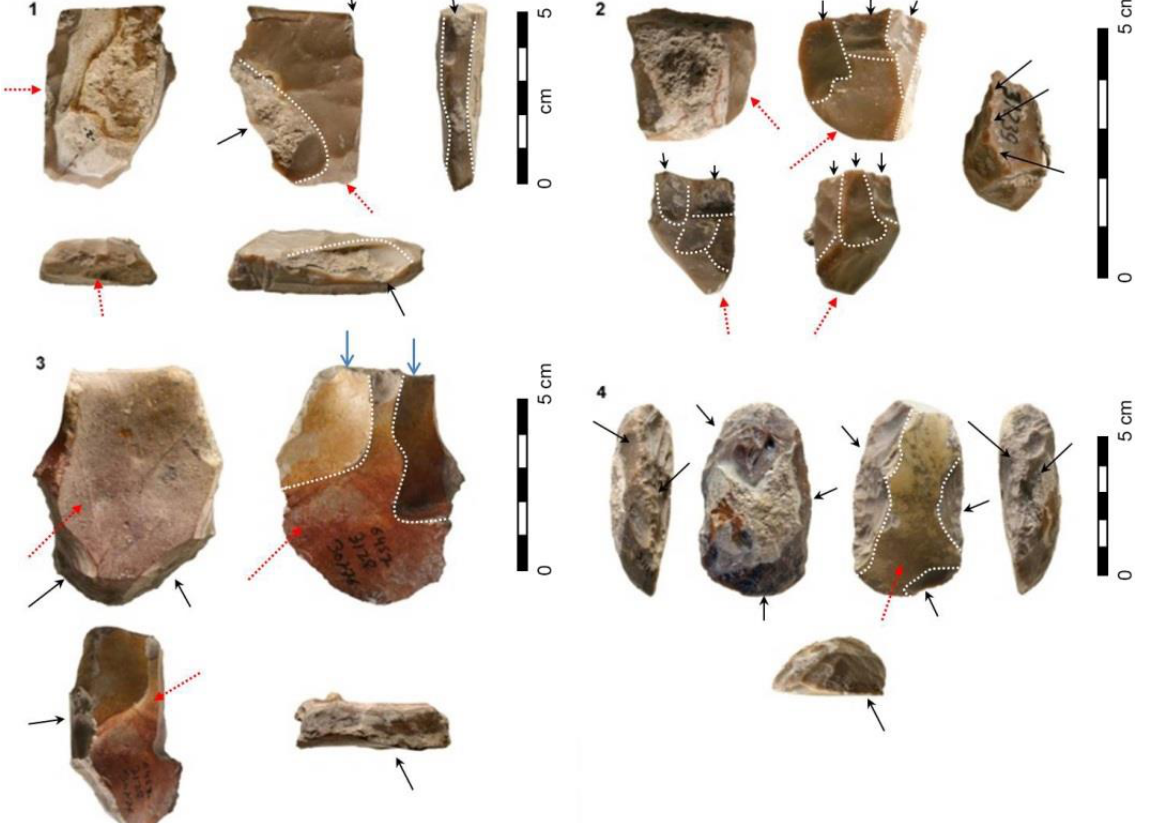
Figure 2. Examples of recycled items: (1 & 2) broken polished bifaces (the polish surface indicated by dotted red arrows) recycled into cores, as the removals are conducted from the broken surface and cut the bifacial scars (the removals are indicated by black arrows; dotted white line outlines the scars of removals after the biface were broken); (3) a patinated large flake recycled as a core-on-flake (COF) (the COF removals are indicate by blue arrows. The flake was produced,, probably discarded, then covered with red patina (the patina indicated by dotted red arrows) and in a later stage recycled as a core-on-flake and then again, as a scraper as indicate by post patina retouch (post patina retouch is indicated by black arrows). The post patina removals indicate a time gap, which perhaps imply that the item was collected and recycled by a different group from the original one that discard of it; (4) a large patinated flake that was probably discarded, covered with yellow patina (the patina is indicated by dotted red arrows), and then recycled into a biface as indicated by the post patina bifacial retouch (the post patina bifacial retouch is indicated by black arrows). This case, as well, shows a time gap between the time of discard of the flake, its patination, and the collection of the item and the recycling of it into a biface, probably by different group than the original group who discarded the large